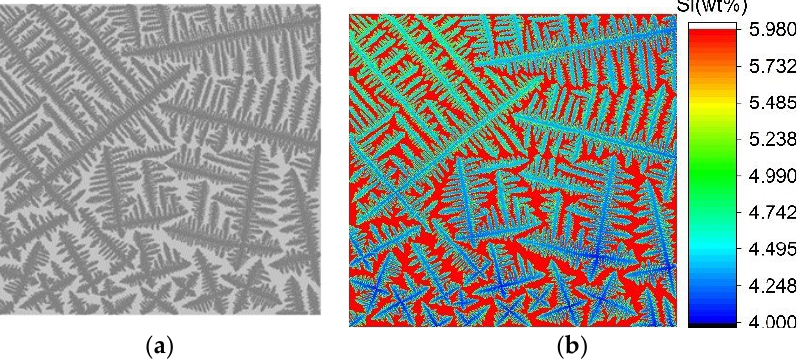
Figure 8. Muti-dendrite morphology of Fe–5.3Si alloy simulated by present model ( a ) morphology, and ( b ) solute profile.